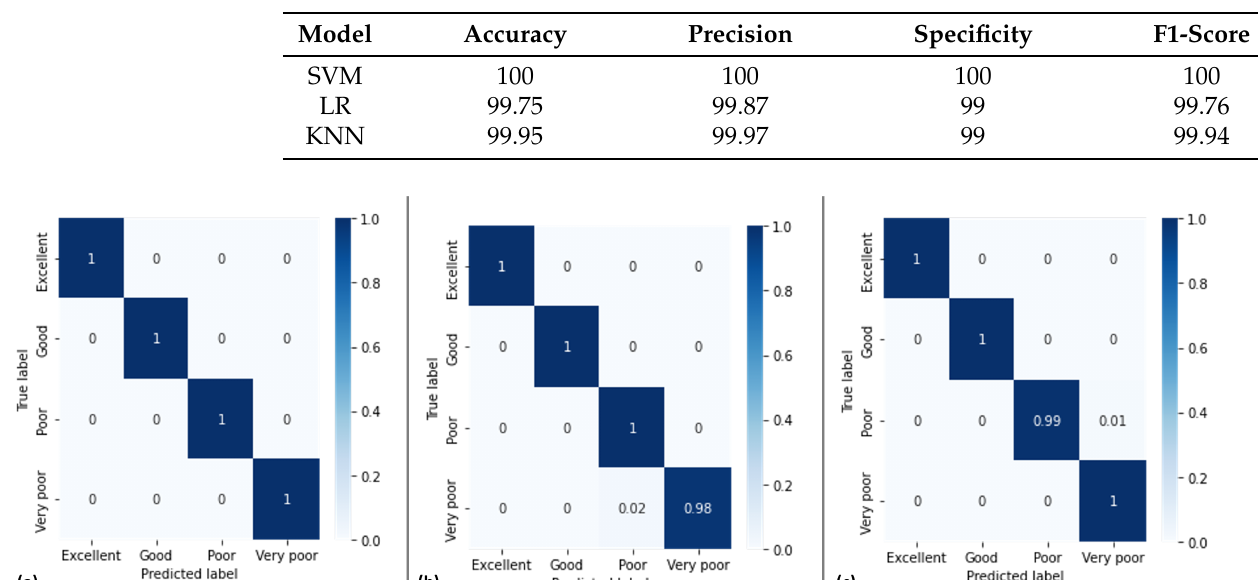
Figure 10. Normalized confusion matrices for the water zones’ embedding classification with: